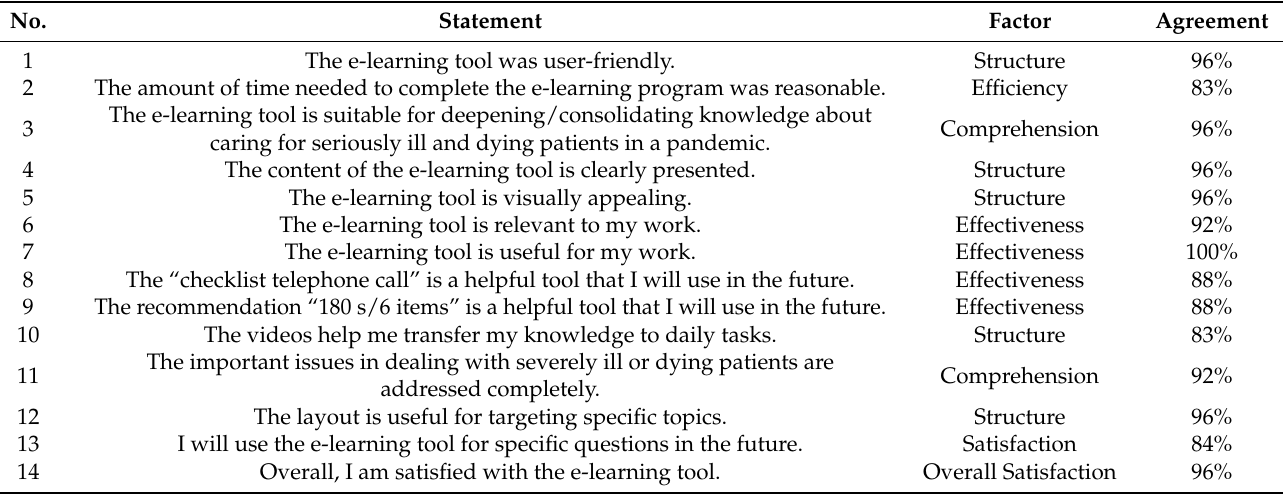
Table 3. Feasibility and agreement in